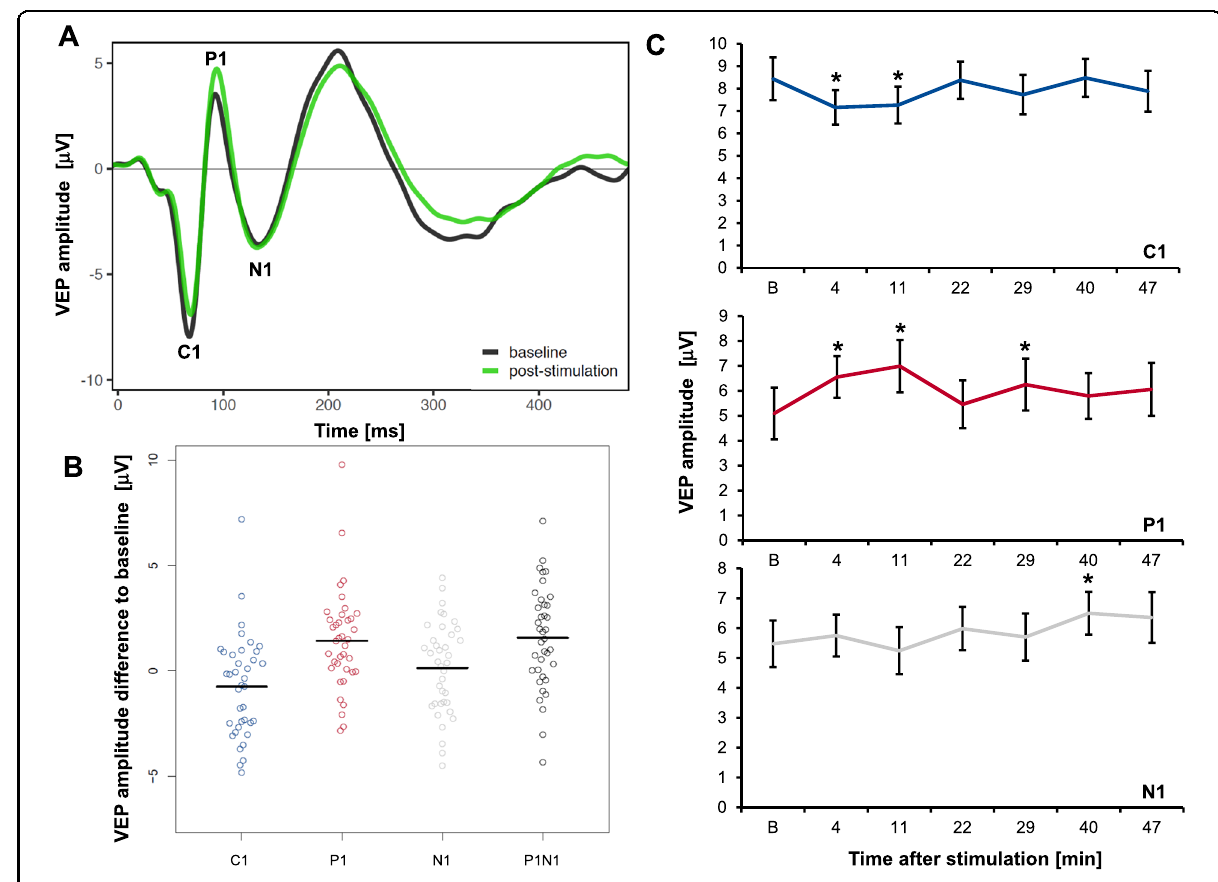
Fig. 5 Combined tDCS- and PVS-induced VEP plasticity ( n = 38, PVS + /tDCS + ). A Checkerboard reversal VEP traces before (black) and averaged poststimulation VEPs (green) after 10 min of occipital anodal tDCS parallel to the presentation of a 10-min checkerboard reversal stimulation block. B Change in peak VEP amplitudes averaged after stimulation compared to baseline peak amplitude (horizontal line, mean). P1 and P1N1 increased signi fi cantly. C Mean peak amplitudes of C1, P1, and N1 VEP components over time + / − SE. Asterisk indicates signi fi cant post hoc contrast of baseline peak amplitude [B] compared to test peak amplitude. VEP visually evoked potential, PVS prolonged visual stimulation, tDCS transcranial direct current